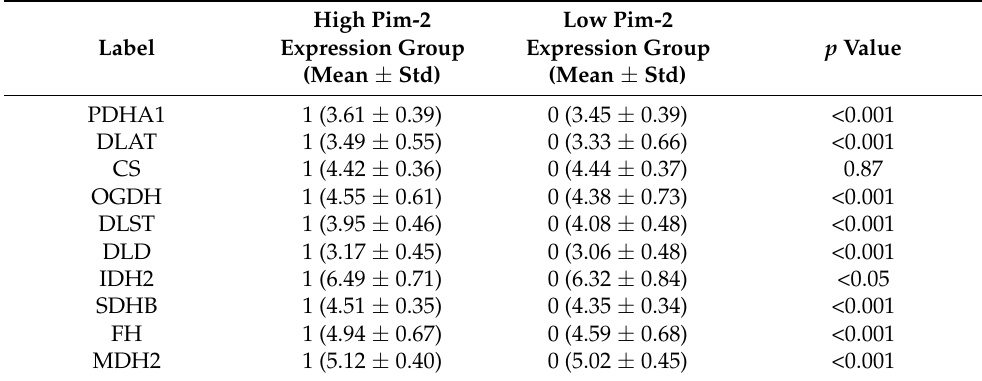
Table 2. Relative expression levels of genes related to